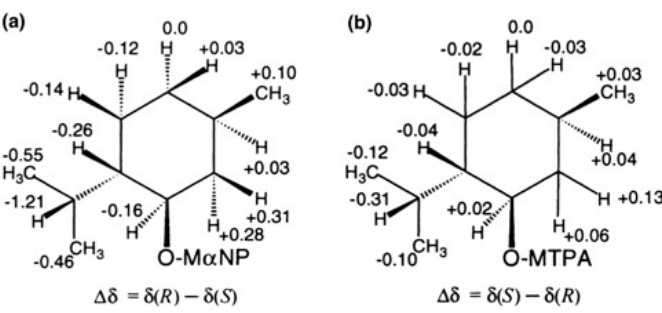
Figure 37. Distribution of ∆δ values in ppm and AC determination. ( a ) Menthol M α NP esters and ( b ) menthol MTPA esters. Reprinted with permission from [51].